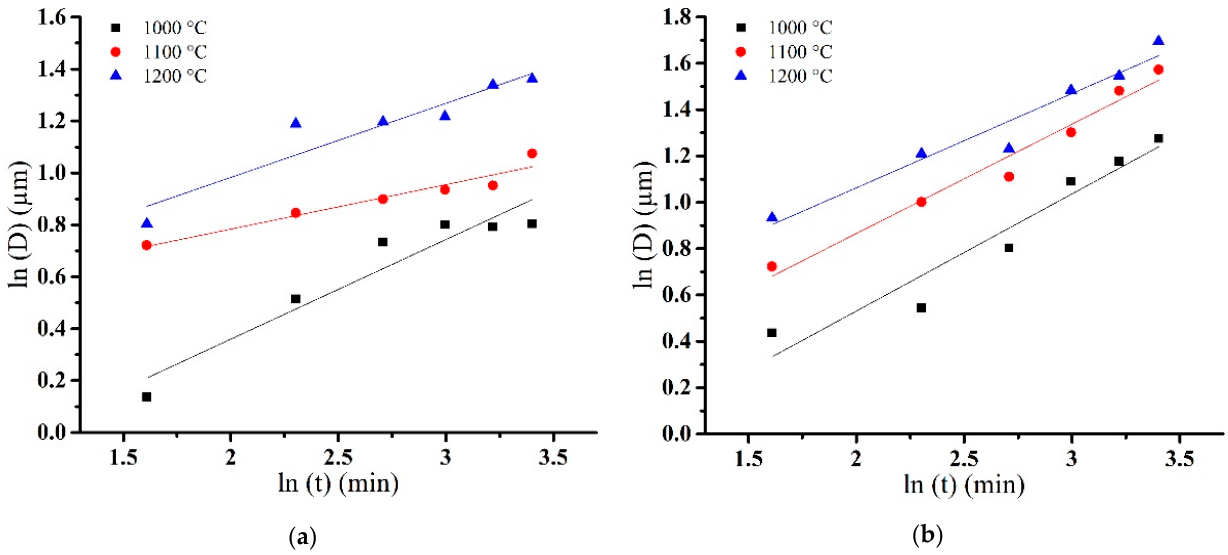
Figure 5. The linear fit dependences of iron grain average Feret diameter on temperature in the LnD − Lnt plot for the RM roasting without additives ( a ) and with 13.65% Na 2 SO 4 ( b ). There is clear evidence in Figure 5 that the straight lines show acceptable linear correlation between lnD and lnt at different temperatures for both cases, without additives and with 13.65% Na 2 SO 4 . After the calculation of mean n for different temperatures for both the processes, the D 1/n − t plots were calculated. Figure 6 demonstrates the plots. The values of Q G and K 0 can be obtained from the slopes and intercepts of LnK − 1/T plots, respectively. After that, the equations can be obtained for the calculation of the average diameter of iron grains formed during the carbothermic reduction of RM. Figure 7 shows LnK − 1/T plots for both the carbothermic roasting RM without additives and with Na 2 SO 4